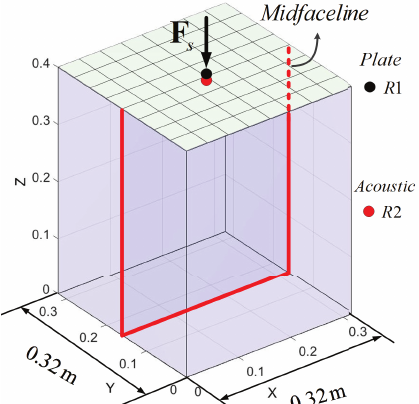
Figure 11. 3D classical vibro-acoustic model.